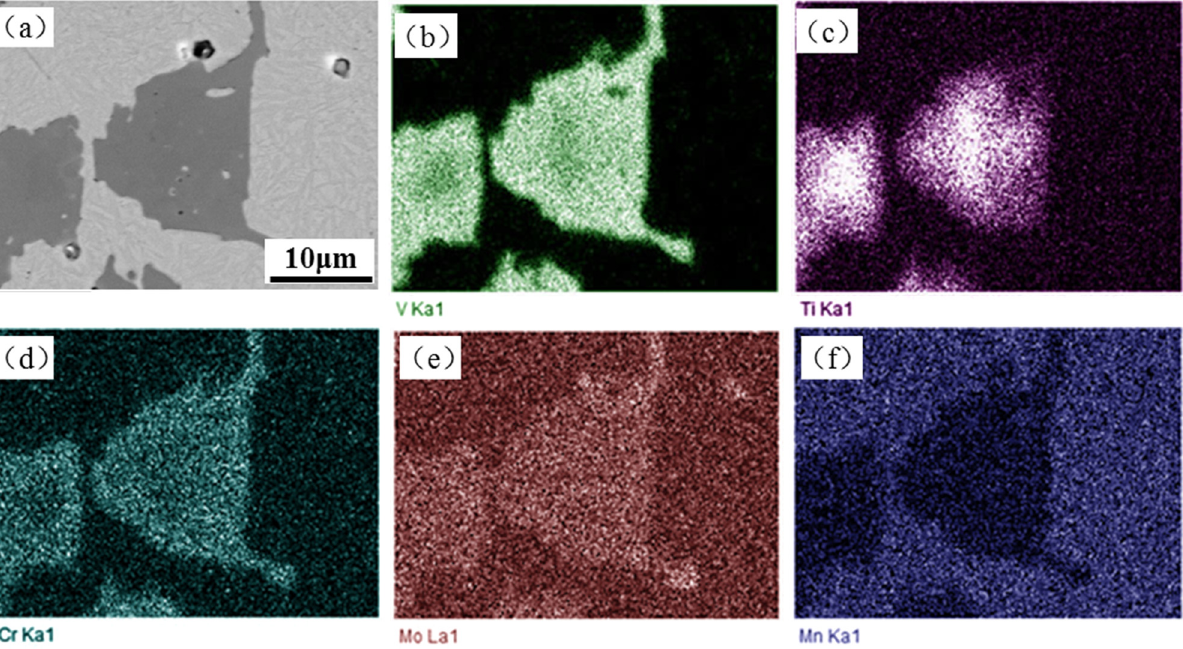
Figure 4: Elemental maps of A1 alloy for 1,800 s partitioning time: ( a )- SEM - BSE image and EDX map for ( b ) V, ( c ) Ti, ( d ) Cr, ( e ) Mo, and ( f )